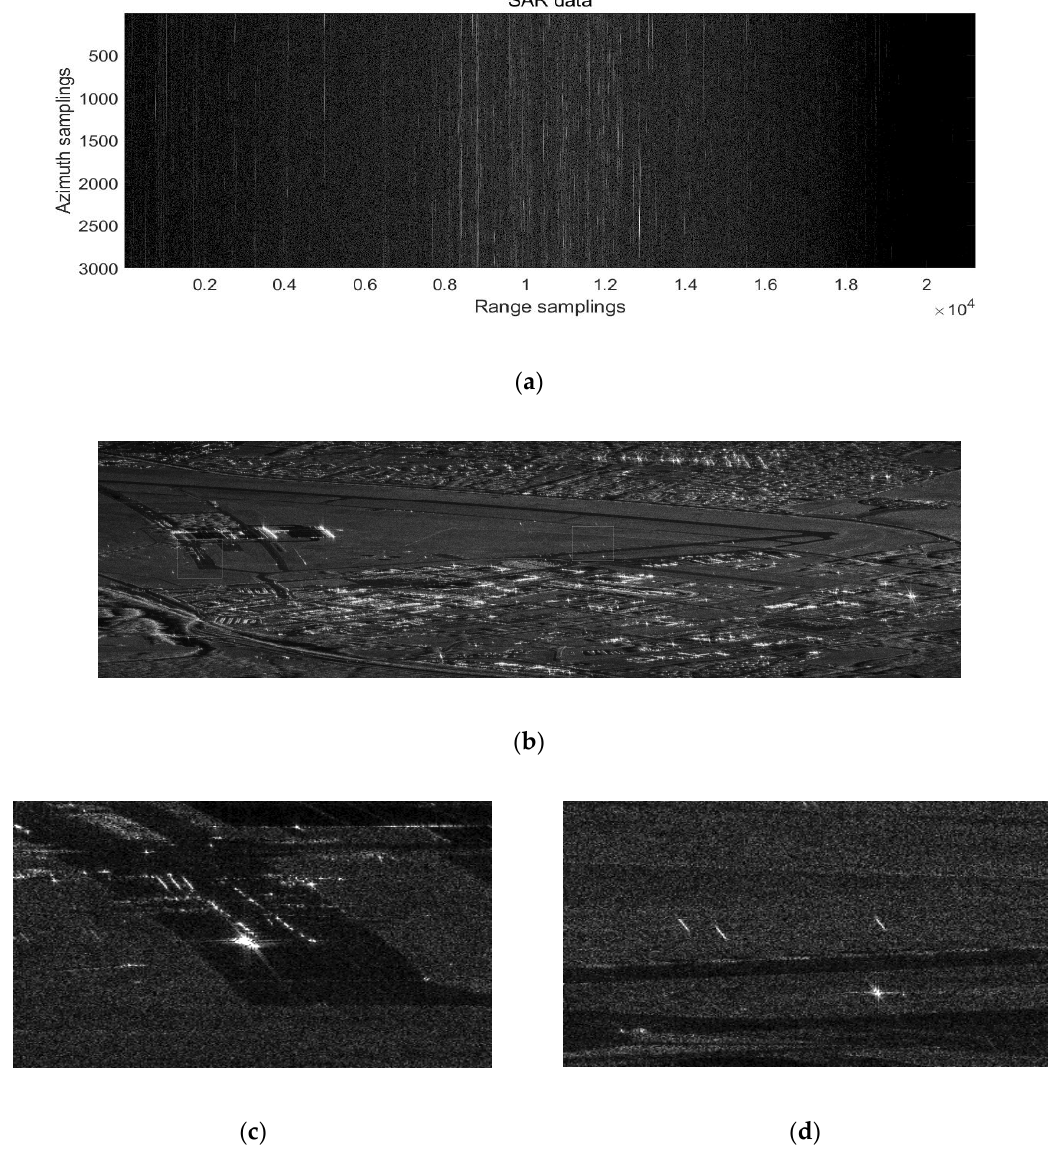
Figure 7. MF and sparse imaging result: ( a ) SAR data, ( b ) scene imagery, ( c ) enlarged rectangular area on the left edge of Figure 7a, and ( d ) enlarged rectangular area on the right edge of Figure 7a.